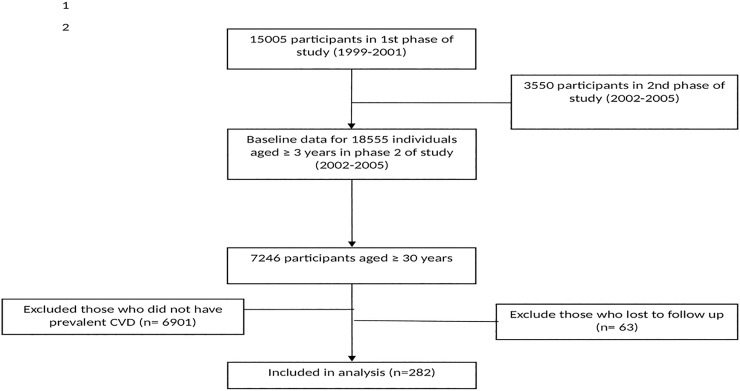
Study population.